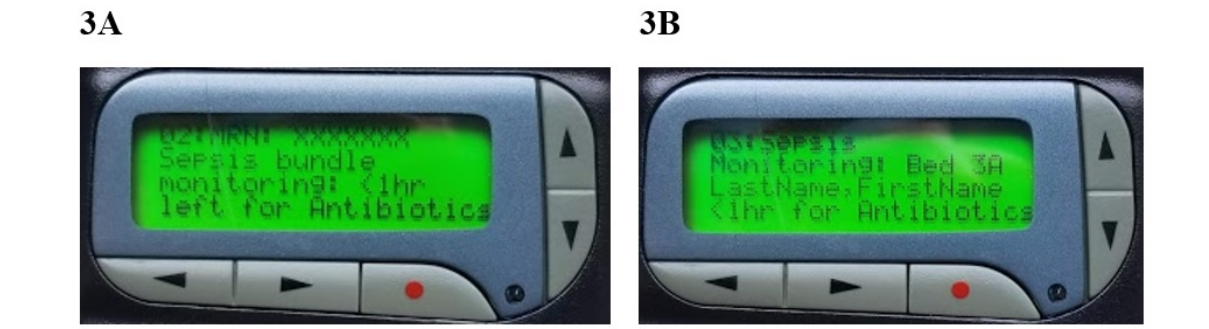
Figure 3. Pilot phase (3A) and rollout phase (3B) pager